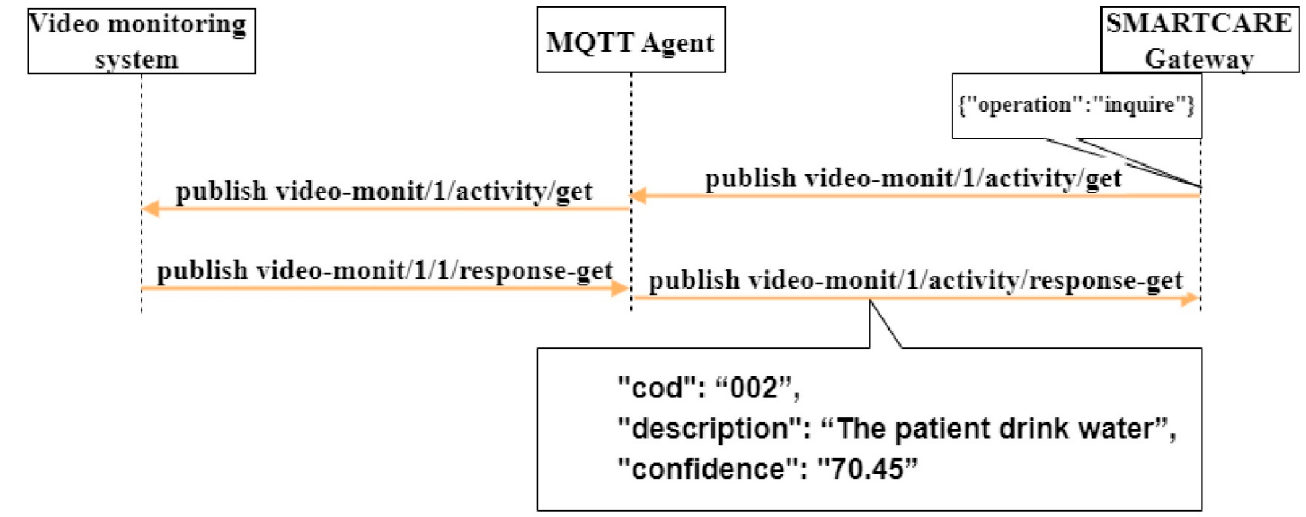
Figure 13. Synchronous communication between the HAR module and the SmartCare system .